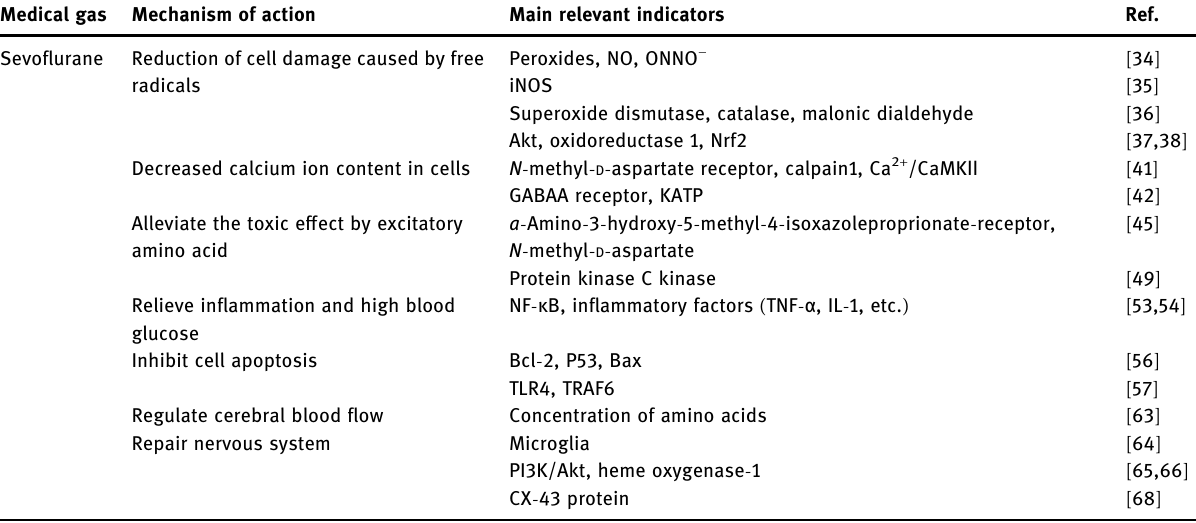
Table 1: Mechanisms and relevant indicators of sevo fl urane in the protection of cerebral ischemia – reperfusion injury Medical gas Mechanism of